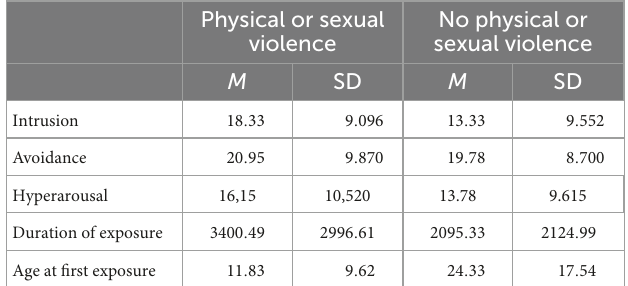
TABLE 1 Mean and standard deviation of the subscales on the impact of events scale, the estimated duration of exposure to violence and the age at the first exposure to violence in the V group contrasting individuals who had experiences physical or sexual forms of violence to those who exclusively experienced other forms.